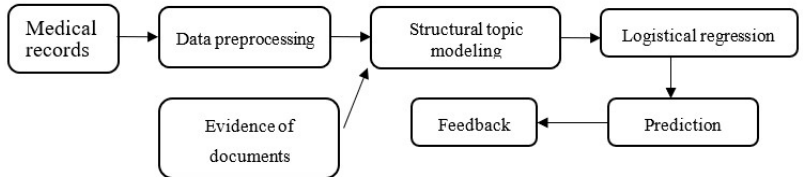
Figure 1. Solution Procedure.